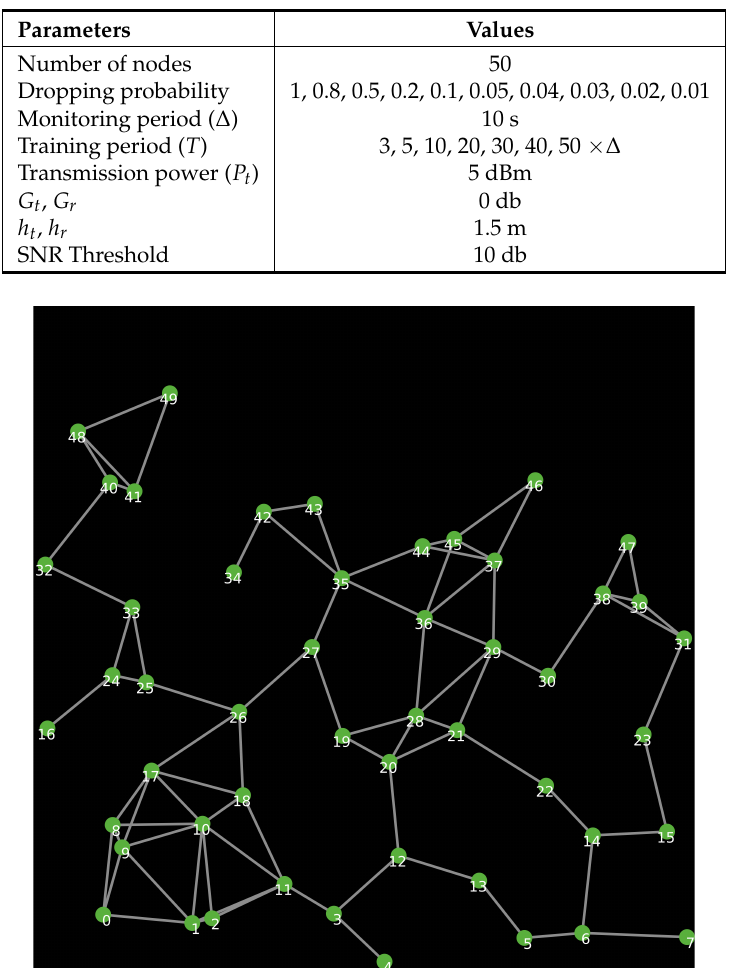
Figure 7. Network